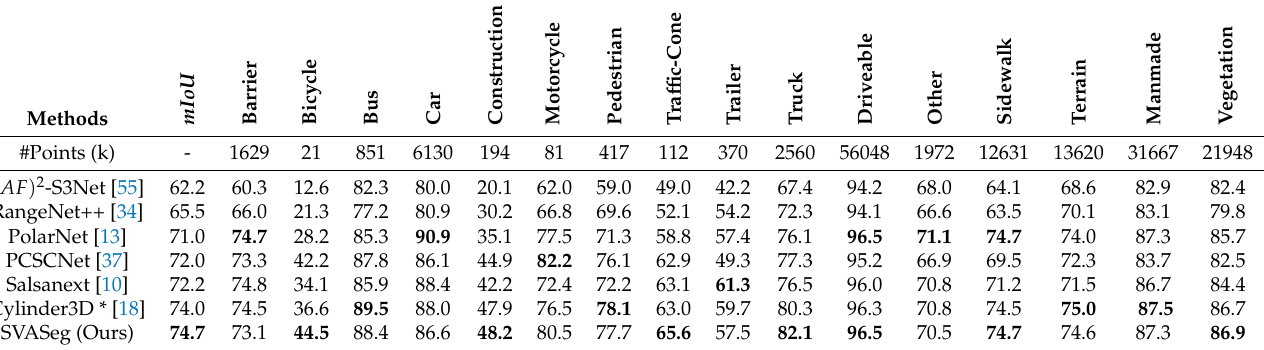
Table 3. Experimental results of our method and other methods on the nuScenes validation set. * is our reproduced Cylinder3D.